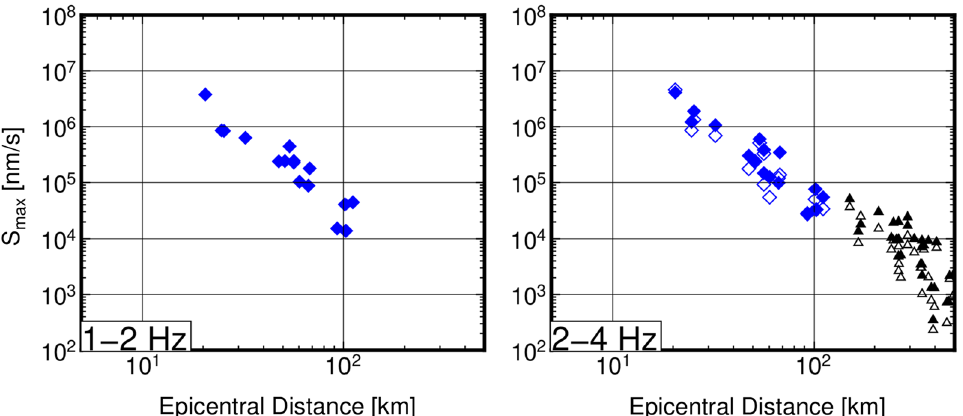
Fig. 6 Attenuation characteristics of the S max amplitude after correction using H/V ratios. The filled blue and open diamonds are horizontal and vertical amplitudes at DONET stations, respectively. The filled and open triangles are those at F-net stations